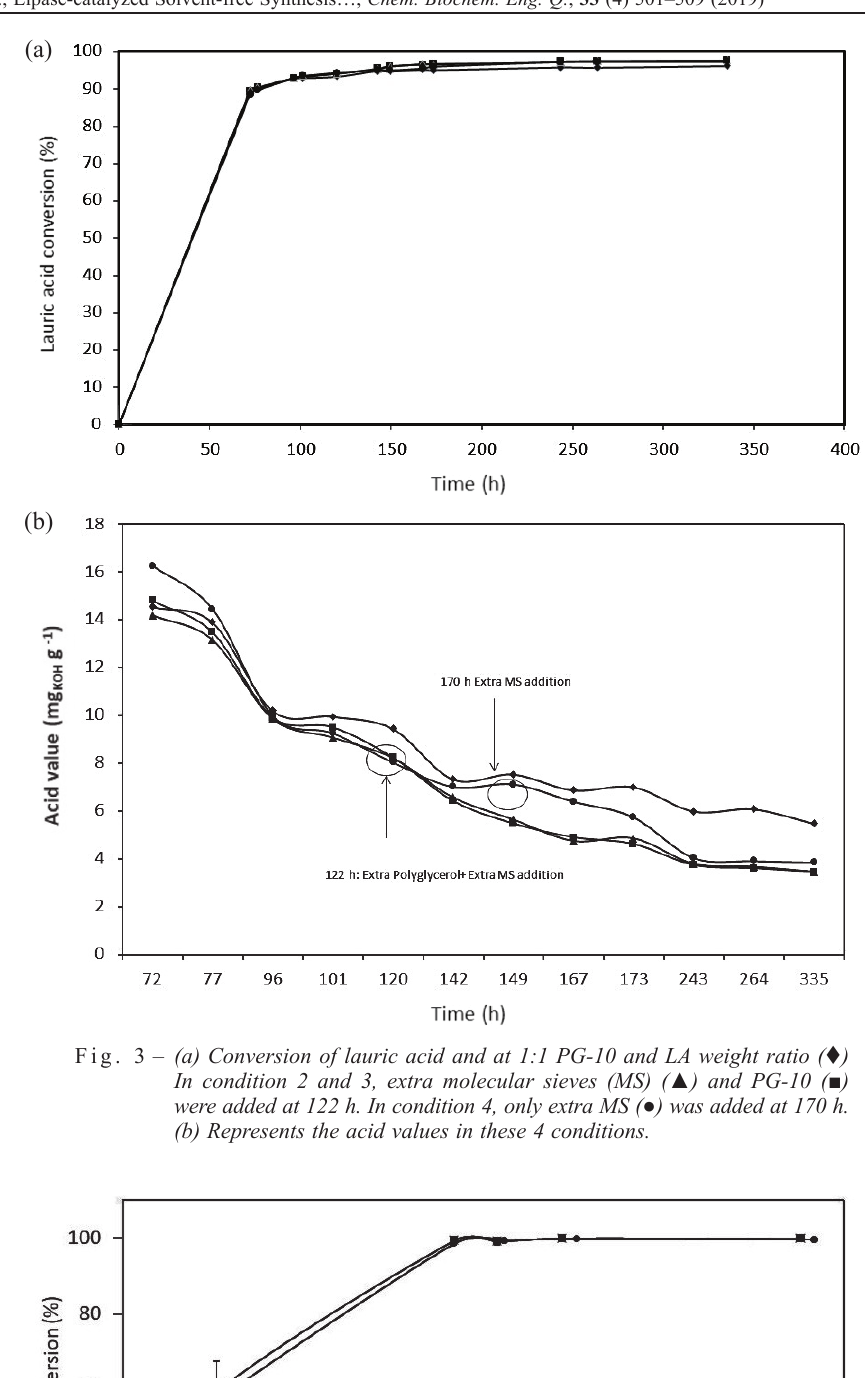
Fig. 4 – Conversion of lauric acid 1:1 PG-10 and LA weight ratio using N ing for water removal in Schott Duran bottle using free (●) and immobi- lized (■)